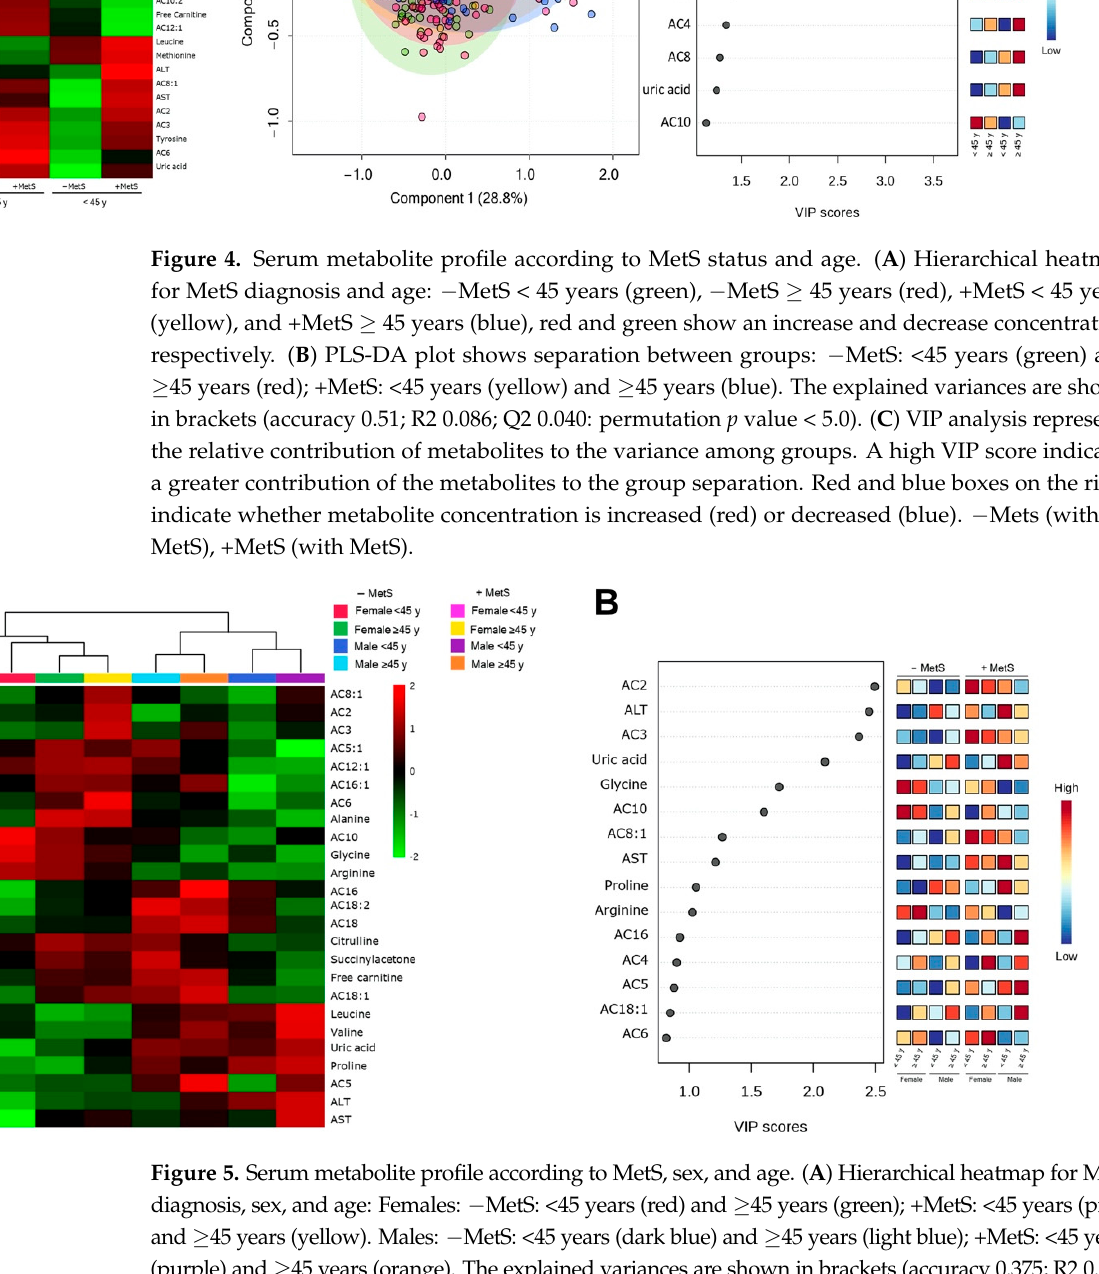
Table 2. Linear models with covariate adjustments.